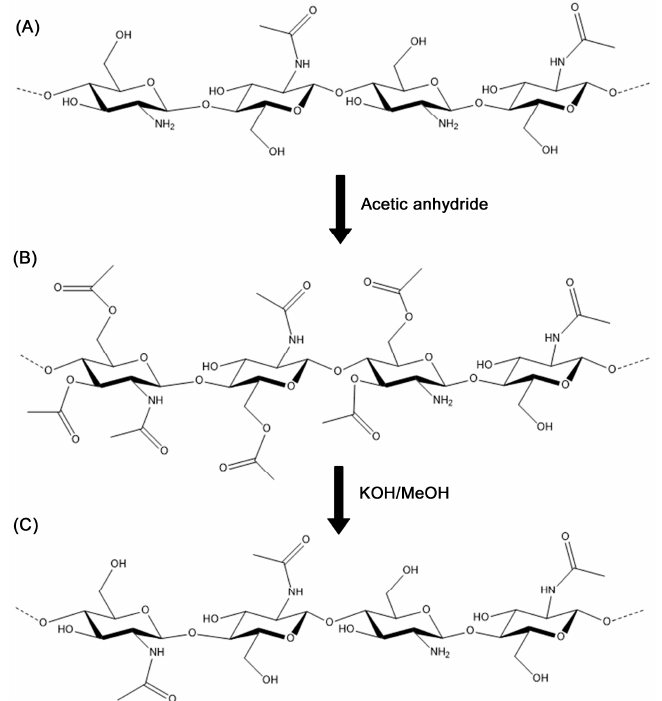
Figure 4. Acetylation reaction showing chitosan ( A ), O-acetylated and N-acetylated chitosan ( B ) and N-acetylated chitosan ( C ). N-acetylated chitosan ( C